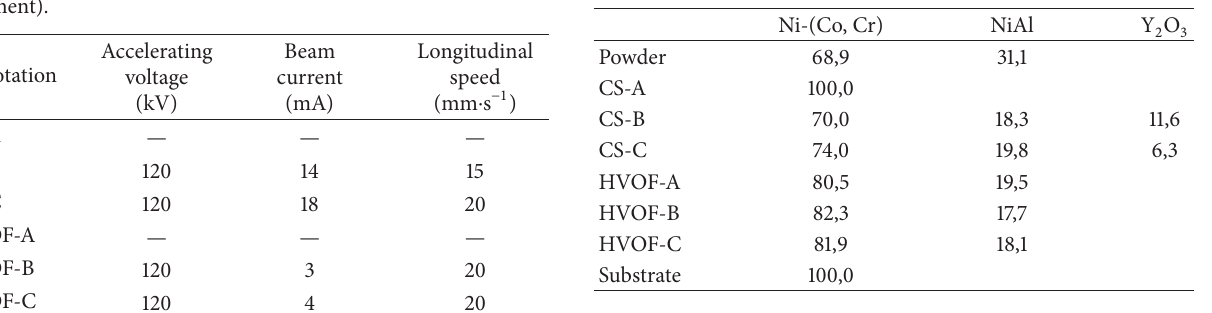
Table 3: Results of phase analyses obtained using XRD